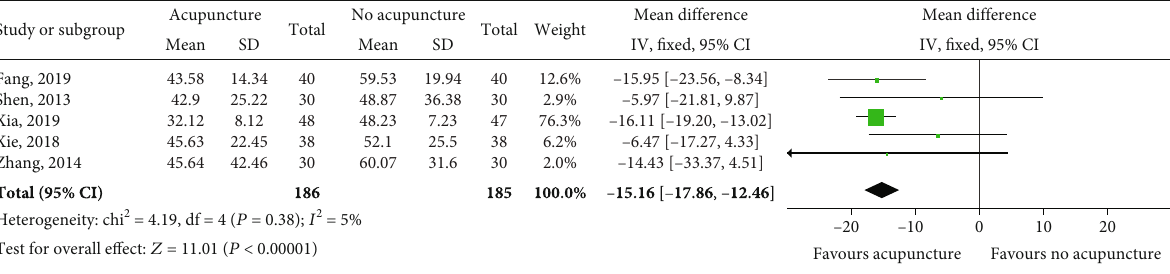
Figure 4: Impact of acupuncture on ALT. Both I 2 and P represent the criteria for the heterogeneity test. ♦ : pooled mean di ff erence; — ■ — : mean di ff erence and 95%